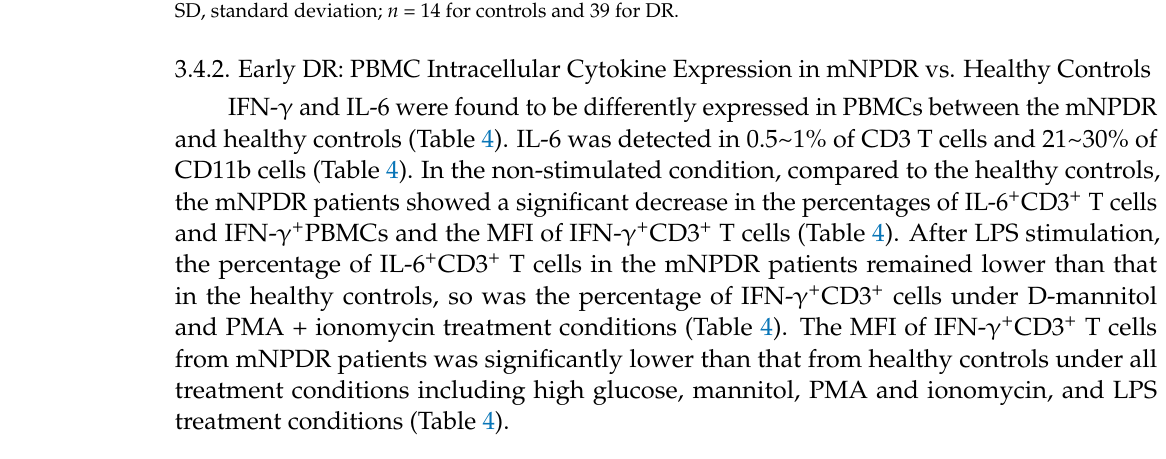
Table 4. Cytokine expression of PBMCs from mNPDR patients vs. healthy controls in different culture